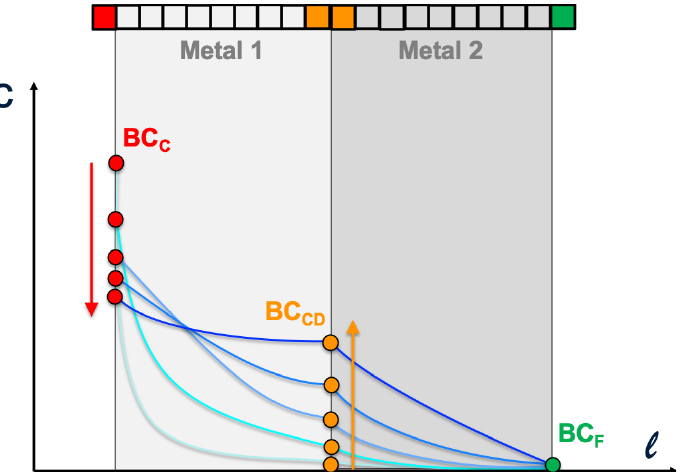
Figure 3. Representation of a generic double metallic barrier being simulated with the proposed model. The nodal division of the barrier provides a mesh along the channel length to apply a numerical method ( top ). In this example, the left side of the barrier experiences a finite amount of gas and the right side is ideally ventilated. The spatial concentration profiles in each metal evolve in time ( bottom , in blue , from light to dark). Furthermore, in this example Sieverts’ constants for both metals are assumed equal, so no profile discontinuity is seen at the interface. Three possible types of boundary conditions (BCs): Coupled BCs (in red ), Co-Dependent BCs (in orange ) and Fixed BCs (in green ). When BC can also evolve in time, this is indicated by an